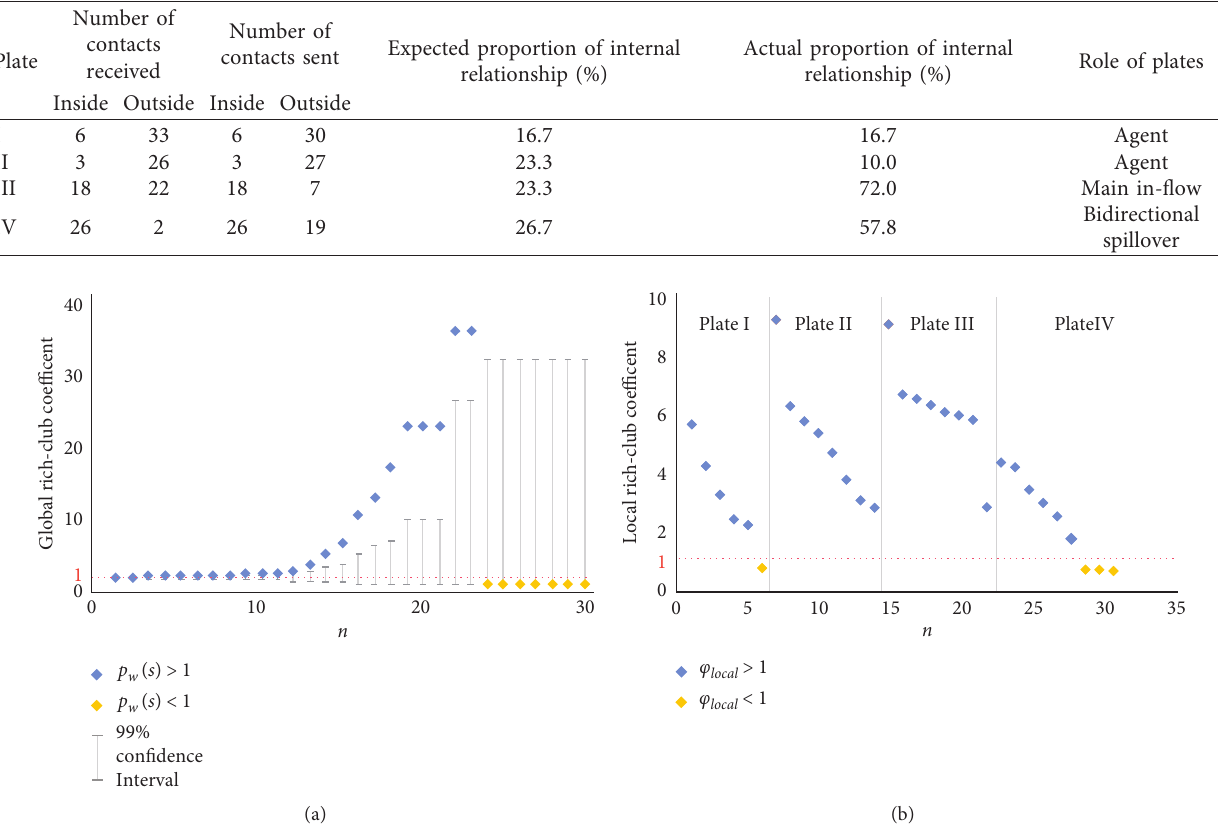
Table 2: Role of the CO 2 emissions in the spatial correlation network.